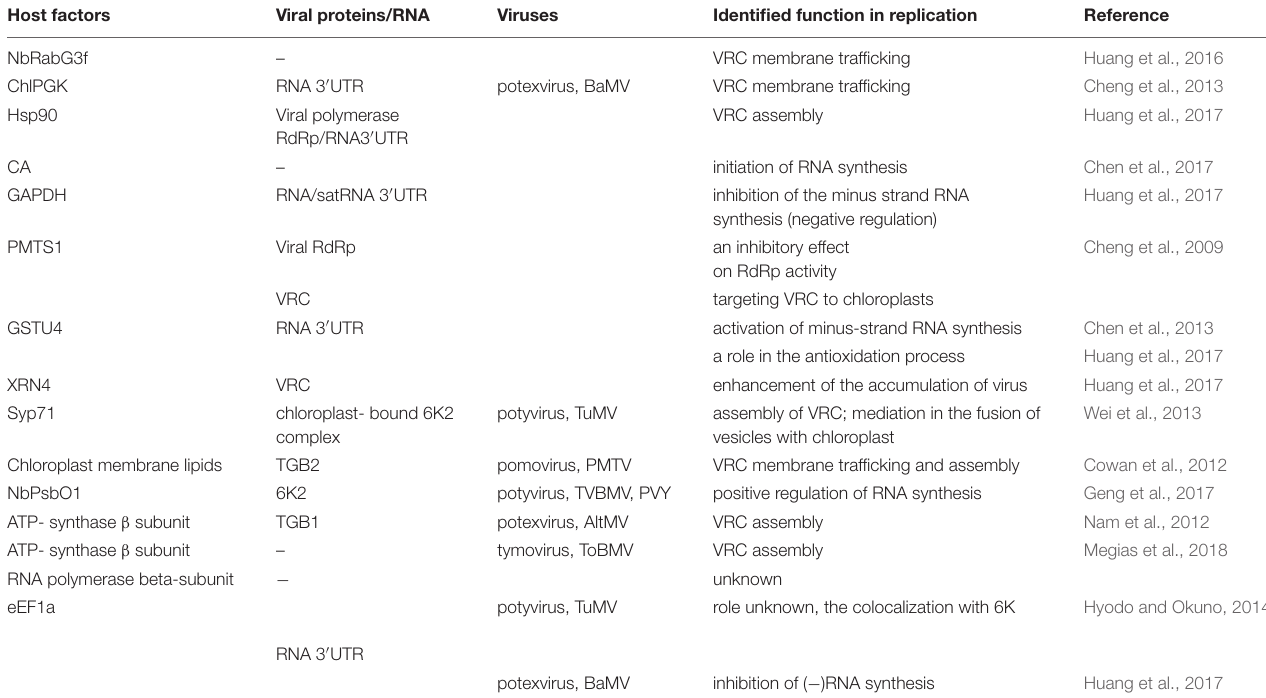
TABLE 1 | List of host chloroplast and chloroplast-related factors and viral protein interactions involved in Synthesis of viral genomic RNA [( + )ssRNA] plant virus